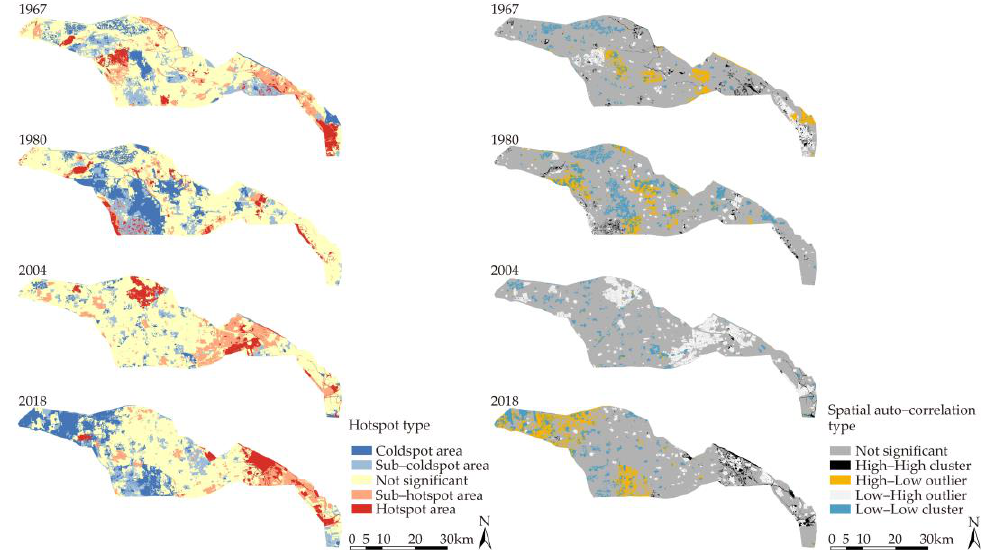
Figure 8. Hotspot analysis ( left ) and spatial auto-correlation analysis ( right ).